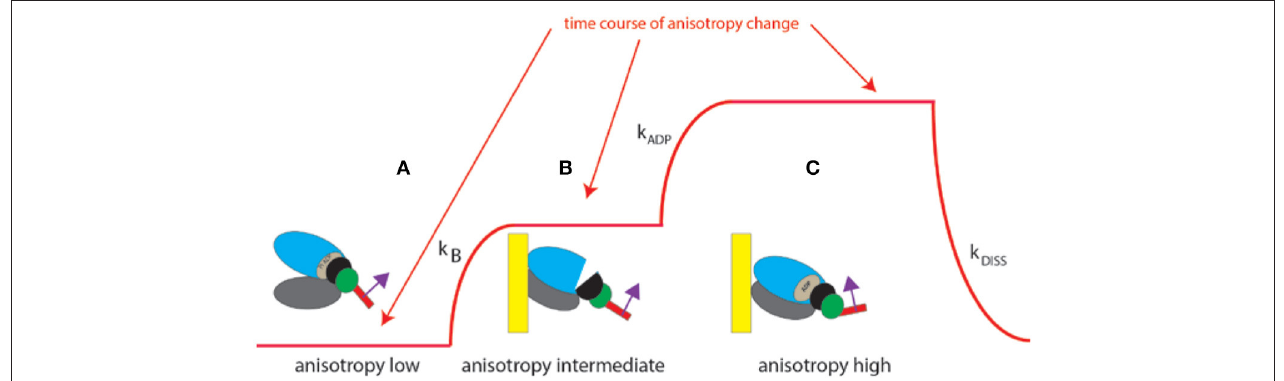
FIGURE 4 | Conformational transitions of 6 XBs during contraction of a ventricle. Red line indicates change of anisotropy. (A) Binding of cross-bridges to a thin filament of a ventricle is characterized by the rate constant k B ; (B) transition from apoenzyme to holoenzyme form of myosin is characterized by the rate constant k ADP ; (C) dissociation of a cross-bridge from a thin filament characterized by the rate constant k DISS .